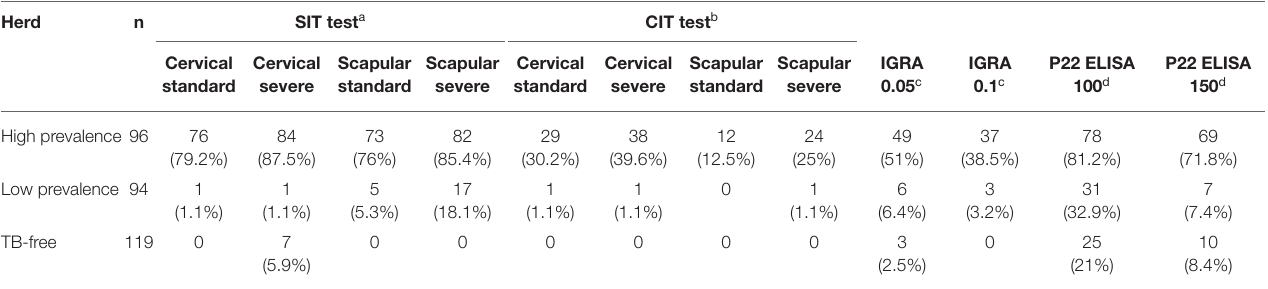
TABLE 1 | Number and percentage of reactors to the SIT and CIT tests (on cervical and scapular sites), IGRA, and P22 ELISA observed in the caprine herds studied herein.